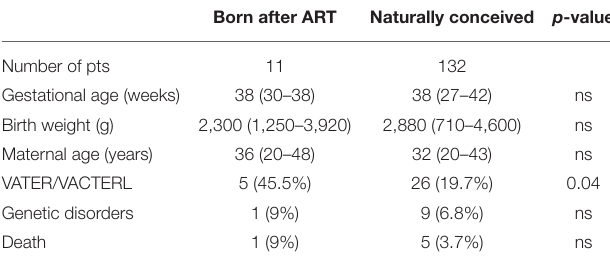
TABLE 2 | Comparison between patients with anorectal malformation born after assisted reproduction technology (ART) or naturally conceived. Born after